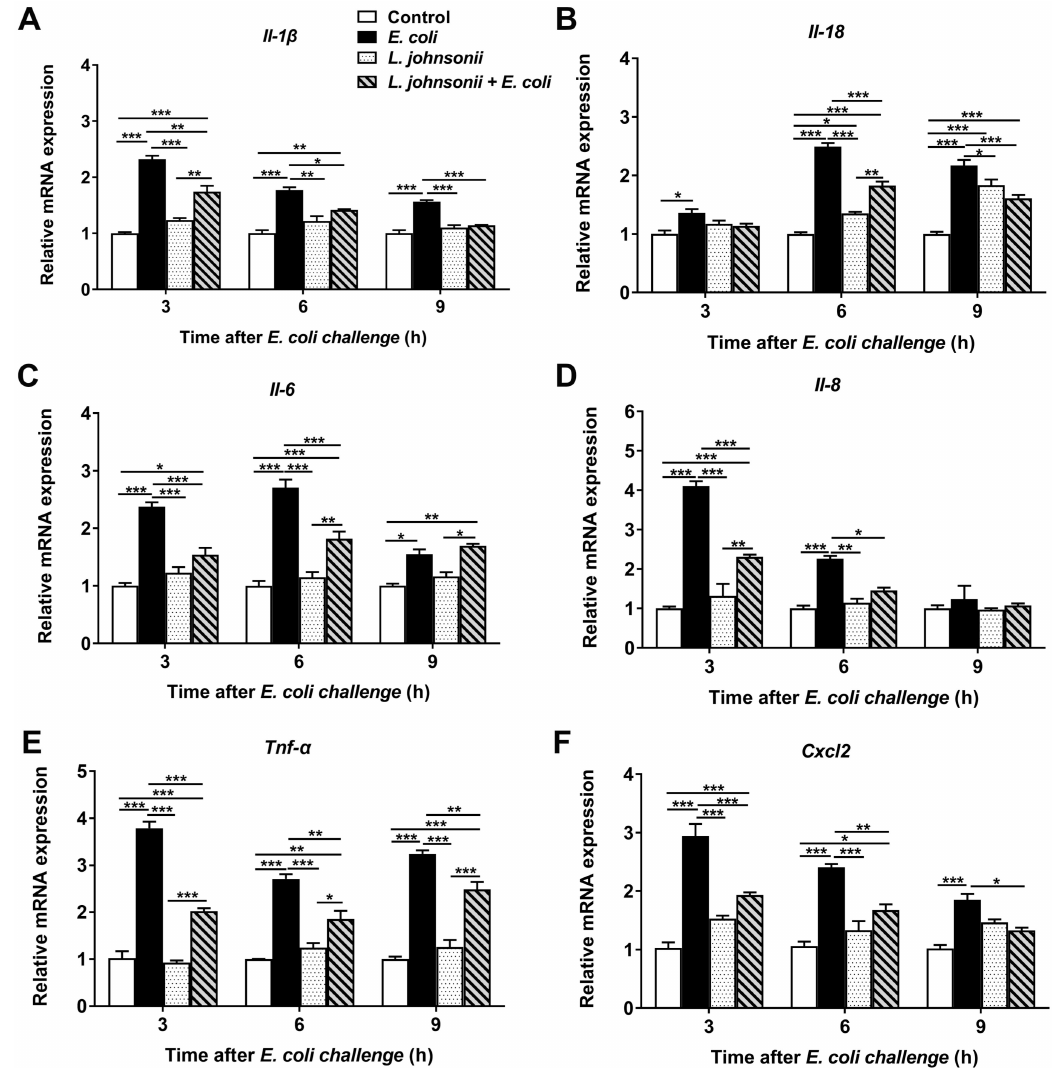
Figure 4. The e ff ect of L. johnsonii L531 on cytokine and chemokine mRNA expression in PMECs infected with E. coli . The mRNA expression of Il-1 β ( A ), Il-18 ( B ), Il-6 ( C ), Il-8 ( D ), Tnf- α ( E ), and Cxcl2 ( F ) in cells obtained from the indicated PMECs at 3, 6, 9 h post-infection was analyzed by quantitative real-time PCR. Data were presented as the mean ± SEM of three independent experiments. * p < 0.05, ** p < 0.01, *** p <